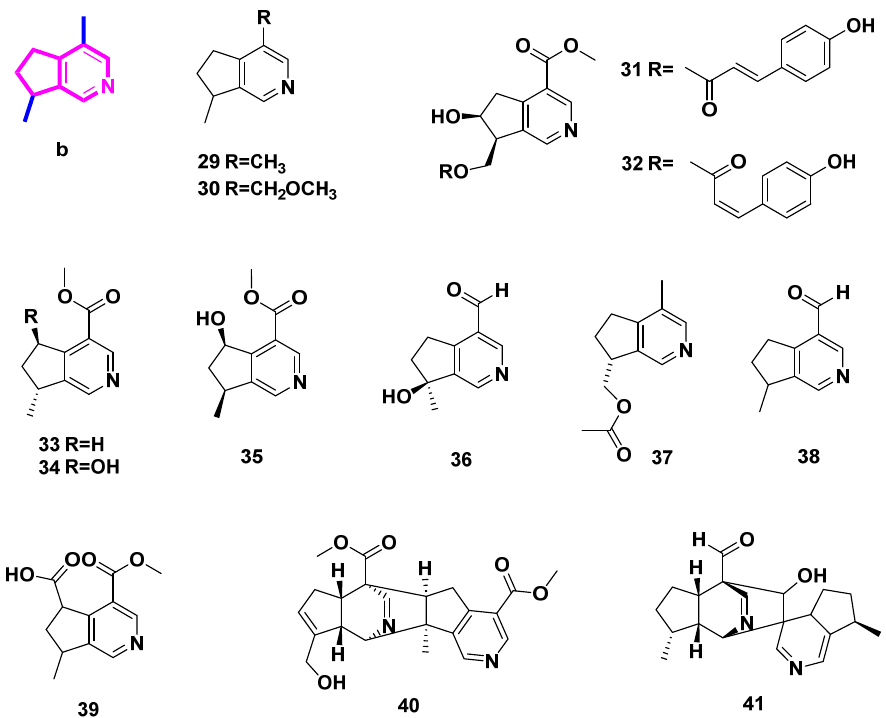
Figure 3. Structures of pyridine alkaloids derived from iridoids (Type II).